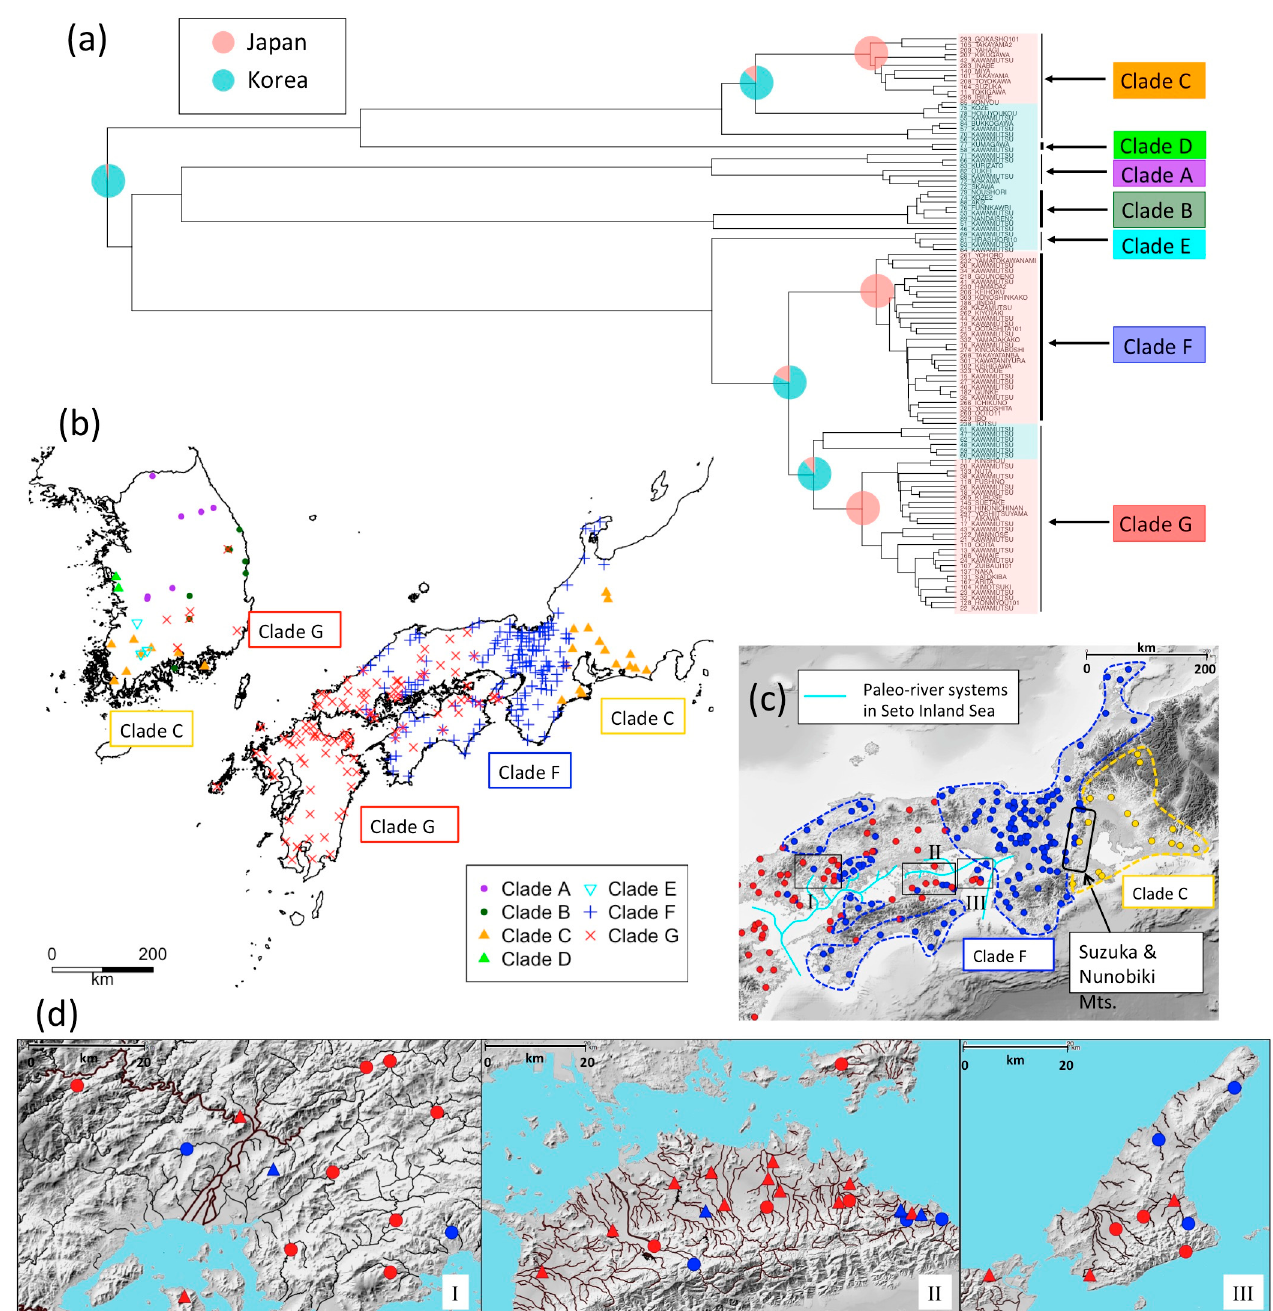
Figure 4. Phylogeny and distribution of Nipponocypris temminckii . ( a ) Bayesian assignment of ancestral nodes to Japan and Korea; ( b ) sample sites by clade; ( c ) distribution of clades on shaded-relief map; ( d ) focused distributions at sites I, II and III. Detailed distributions of individuals for which the type of a clade has been determined by PCR-RFLP analysis are displayed as triangular points ( d ). Colors represent the cleavage types of BstUI, DdeI, and TaqI that correspond to clades F and G (see supplementary information). Paleo-river systems ( c ) modified from original maps [35,36]. At localities I and III, clade F was sampled at sites surrounded by mountains, but at locality II, clade F was sampled upstream and clade G downstream. We used R [16] package GGTREE [37] for visualization in ( a